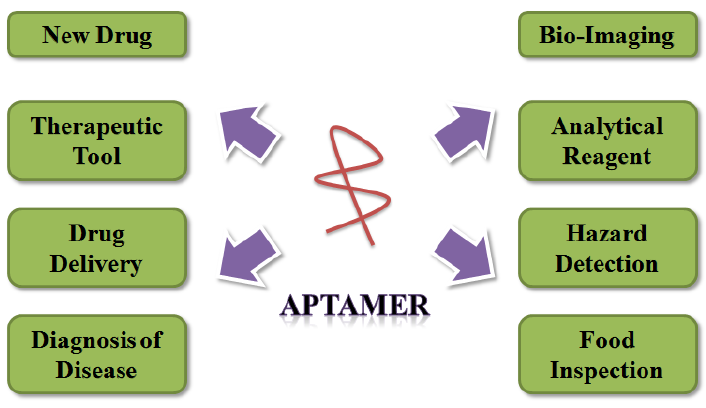
Figure 1. Various application fields of